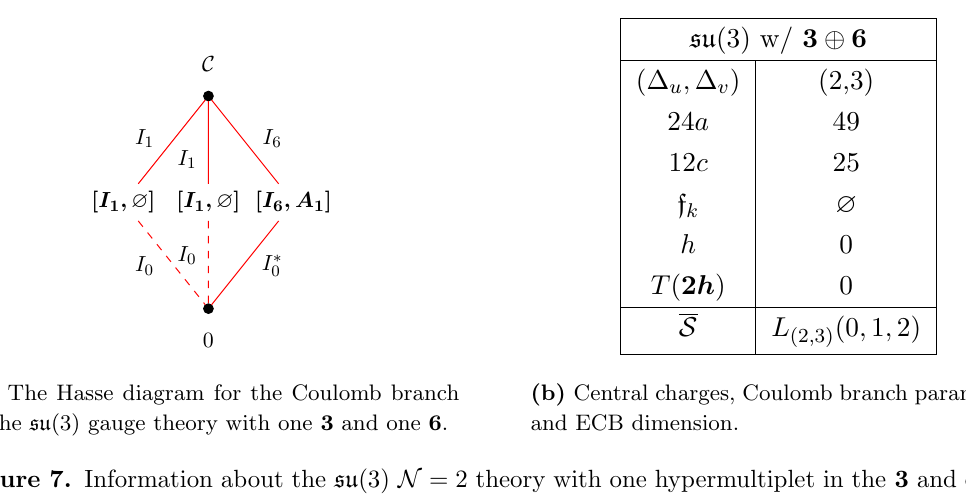
Figure 6. Information about the su (3) N = 2 theory with 6 hypermultiplets in the 3 .